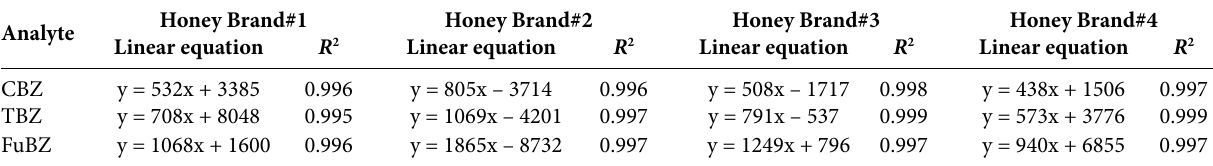
Table 2: Calibrations obtained by the proposed method for the determination of the benzimidazole fungicides in honey samples